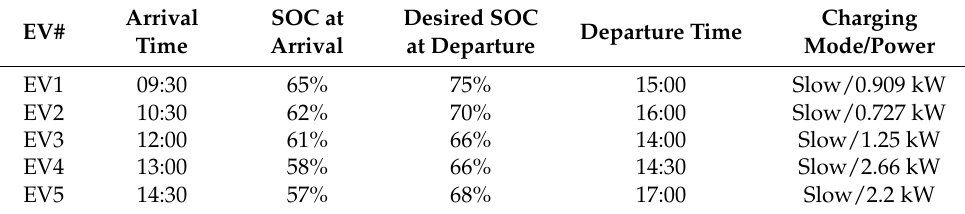
Figure 16. Scenario 2b, system power flows and stationary storage SOC evolution. PV and stationary storage share power to charge the EVs, without the need for the public grid supply. When the PV production is higher than the EV’s demand power, PV charges the stationary storage so it can supply further power afterward. The stationary storage becomes full, reaching its maximum capacity around 12:50, therefore, PV injects power into the public grid. The EVs charging power and EVs SOC evolution for the two scenarios 2a and 2b are shown in Figure 17.